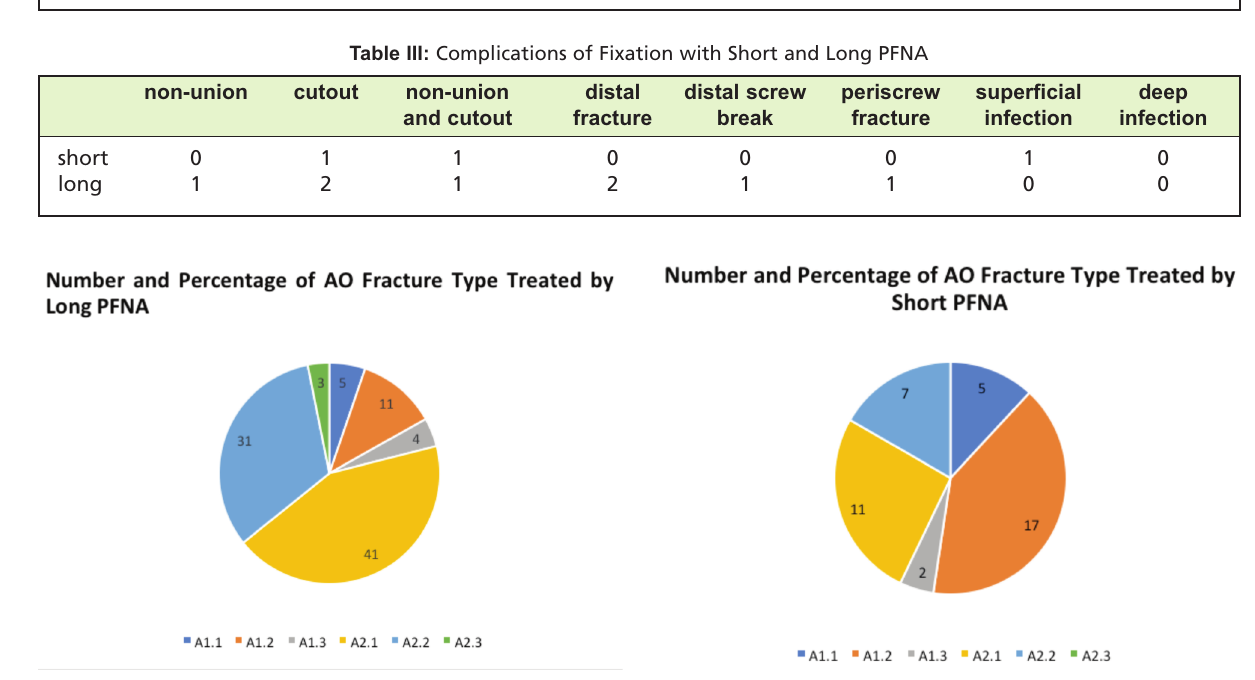
Number and Percentage of AO Fracture Type Treated by Fig. 1: Long PFNA.